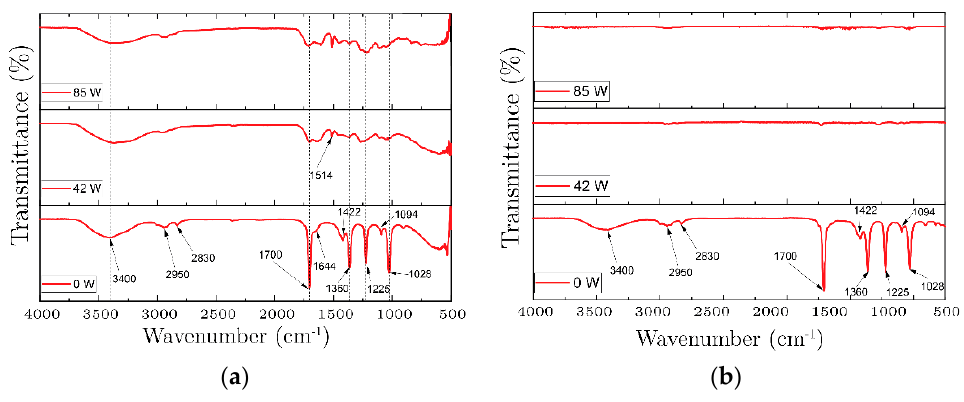
Figure 6. IR spectrum on impinger–1 ( a ) and IR spectrum on impinger–6 ( b ). The peak at 2830 cm − 1 and 1700 cm − 1 correspond to C–H and C=O bonds, respectively, which indicates the presence of aldehyde and conjugated aldehyde in the tar samples. The presence of the C=O bond in BCFM samples is responsible for the green luminescence colour [17]. The C–H bond did not significantly change due to the presence of plasma.